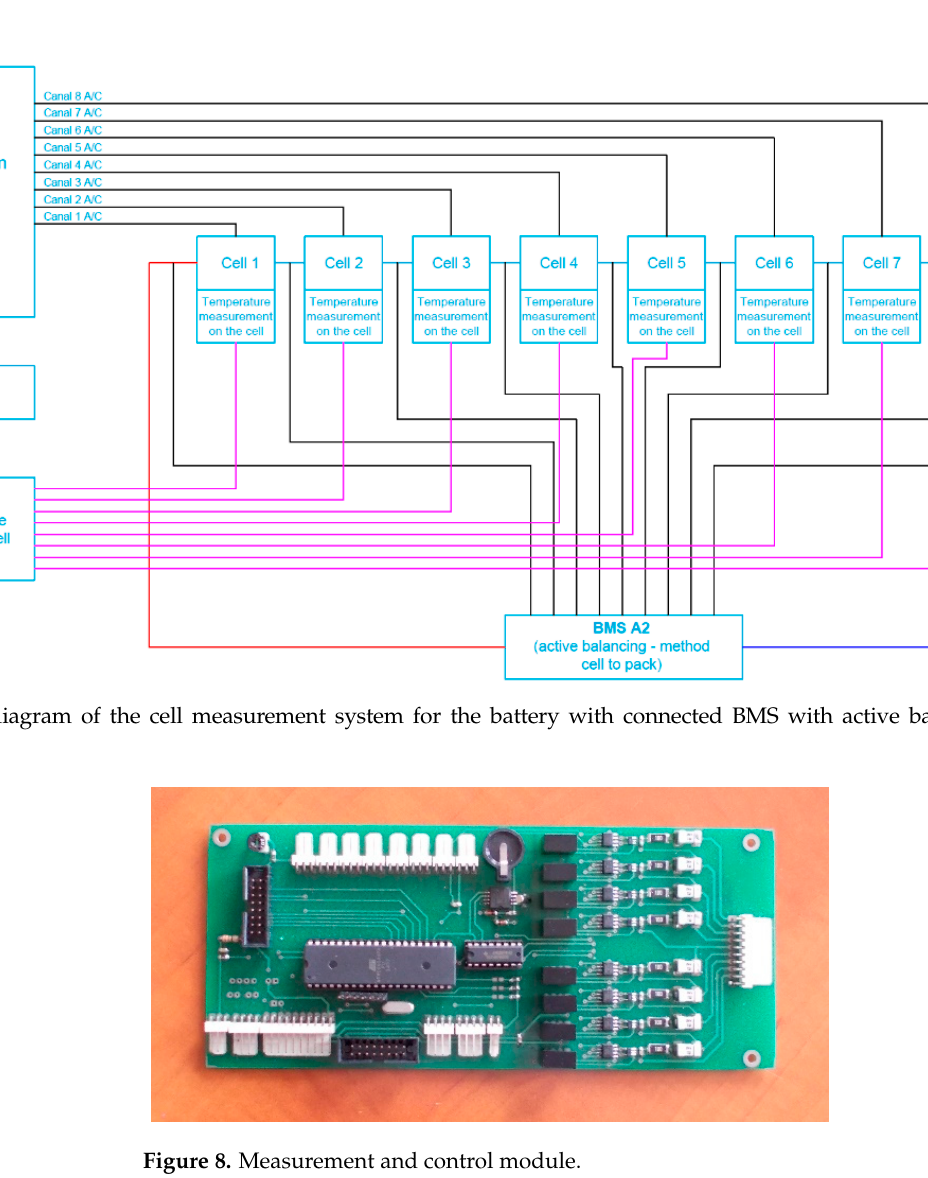
Figure 8. Measurement and control module.